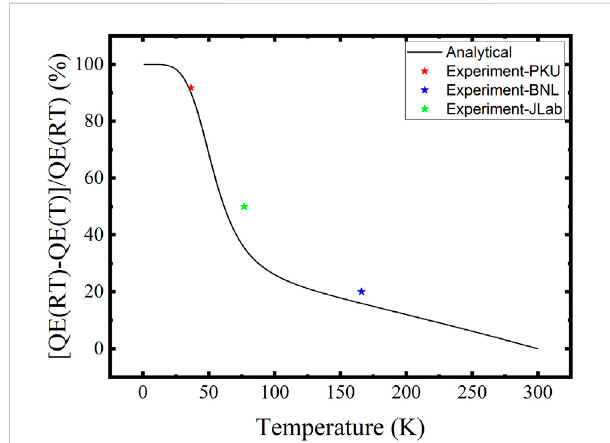
FIGURE 4 Macro-pulse operation results of a QE-degraded K-Cs-Sb sample with a fi xed laser power during each operation. The applied laser power was 375 mW during the CW operation. For macro-pulse operation at the duty cycle of 20% and 50%, the laser power was 75 and 187.5 mW, respectively. The average beam current increased by more than 20 μ A during the CW operation, but there was a minor increase at 20% duty